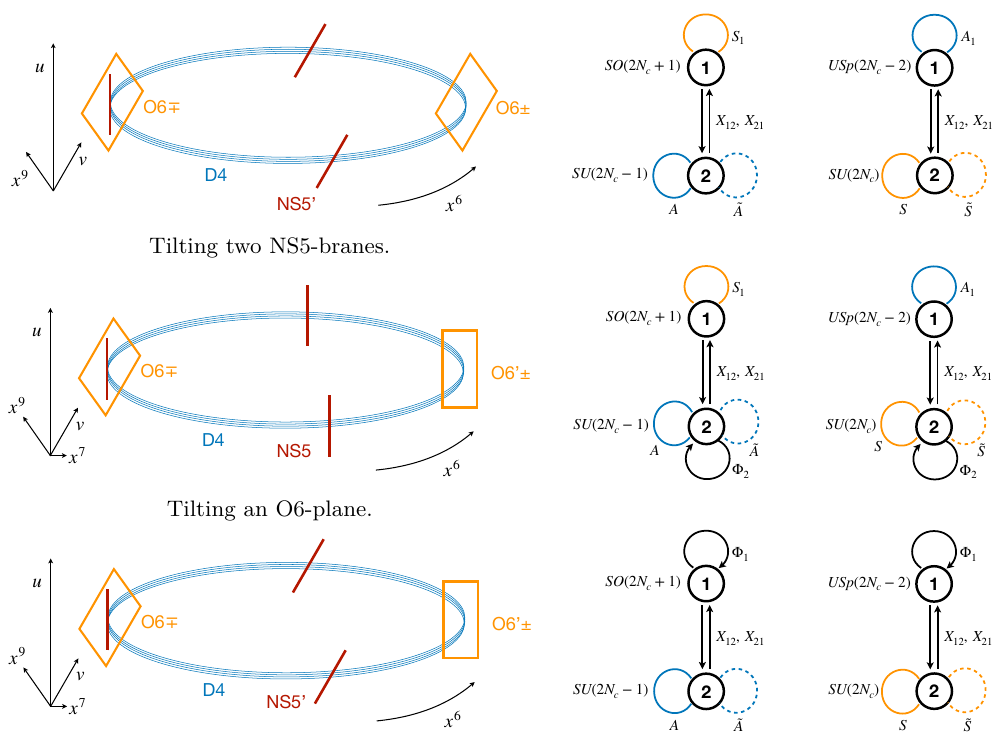
Figure 10 . Examples of N = 1 S-dual quivers with n g = 1 obtained from the same N = 2 elliptic models by breaking supersymmetry in different ways. All the φ therefore we can add the exactly marginal deformation m same quiver for the three